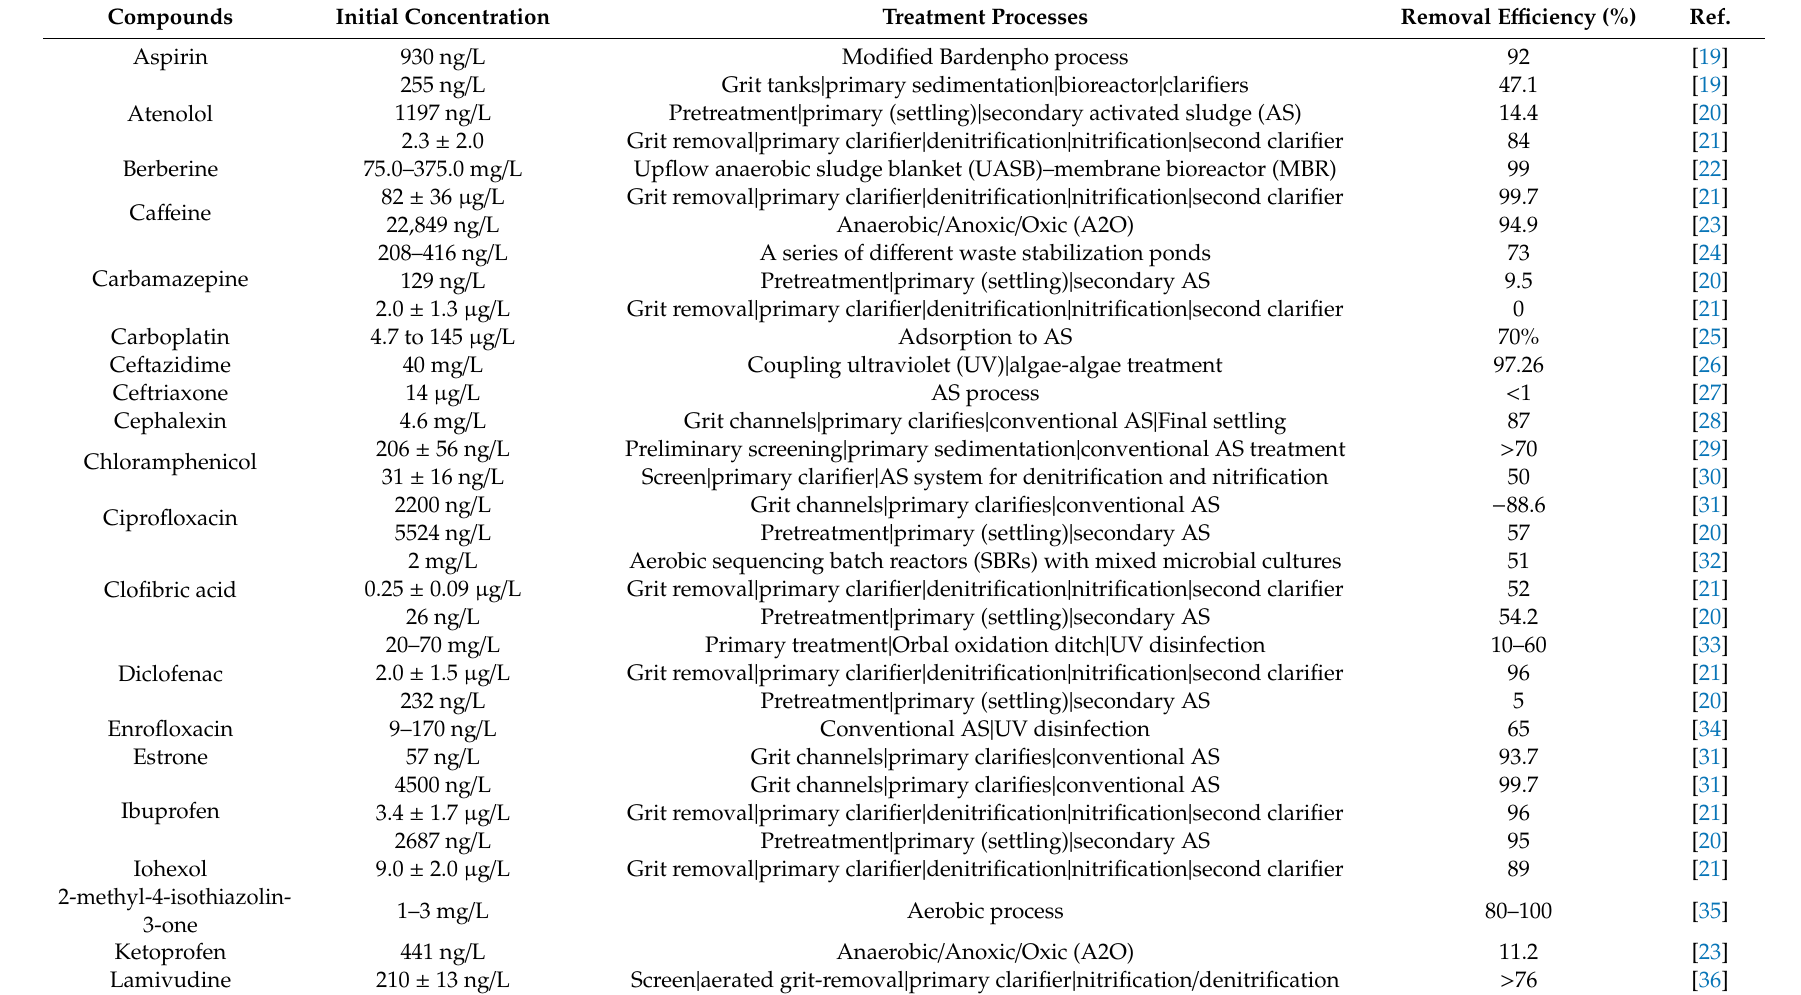
Table 2. The removal e ffi ciency of PPCPs by combining biological treatment with other